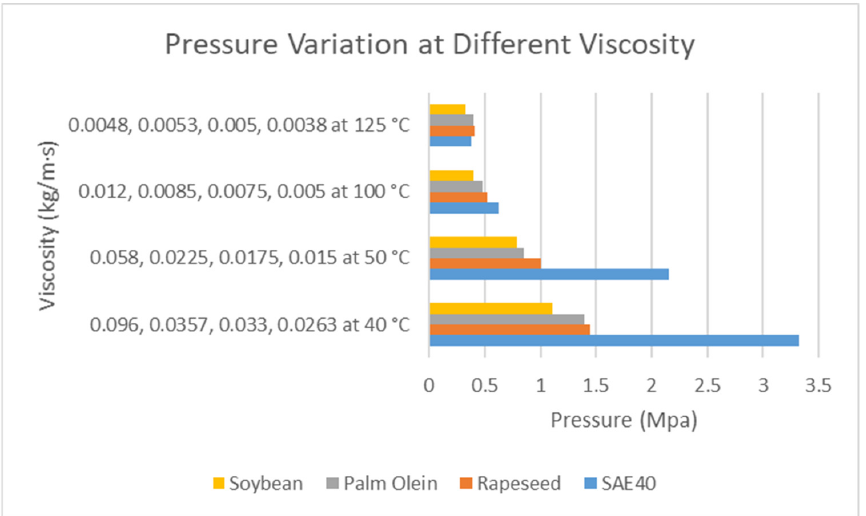
Figure 11. Pressure variation with variable viscosity.